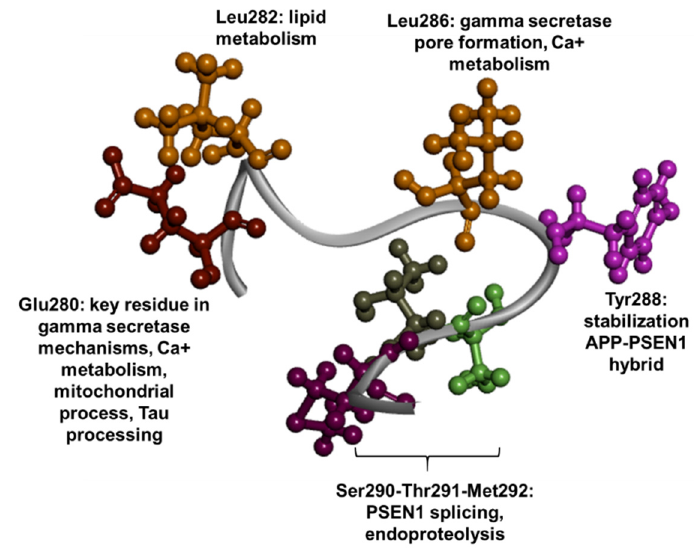
Figure 10 . Significant residues located in the hydrophobic stretch of large loop. Figure 10. Significant residues located in the hydrophobic stretch of large